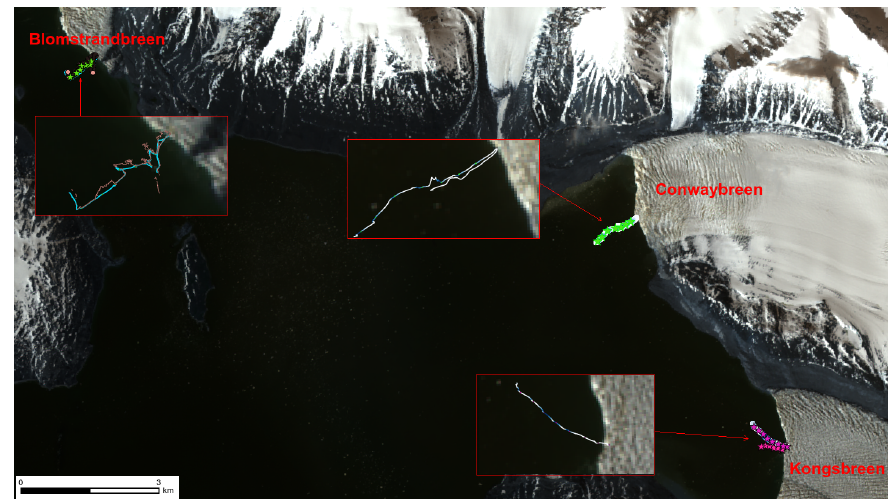
Figure 25. EXCELLABUST project: Map of the testing sites in Kongsfjorden obtained from the processing of Landsat8 data acquired on the same days in which the tests took place. The boxes show examples of GPS trajectories followed by PROTEUS USSV during data acquisition.